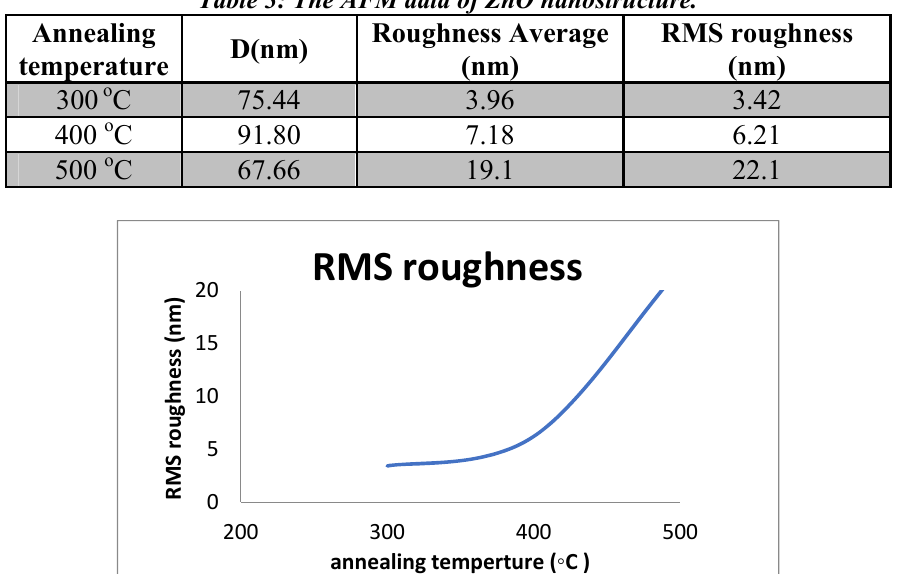
Fig.5: The RMS roughness of ZnO nanostructures at different annealing temperature. Fourier Transform Infrared Spectroscopy (FTIR)